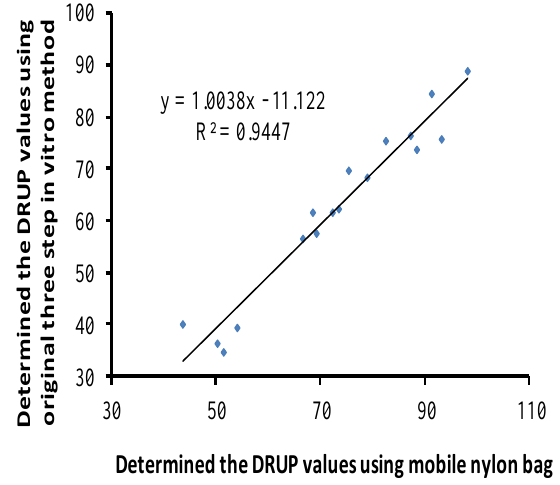
Figure 6. Predicted analysis between MNB observed values and OTS observed values in all the samples. DRUP, digestibility of rumen undegradable protein; MNB, mobile nylon bag method; OTS, original three-step in vitro method.